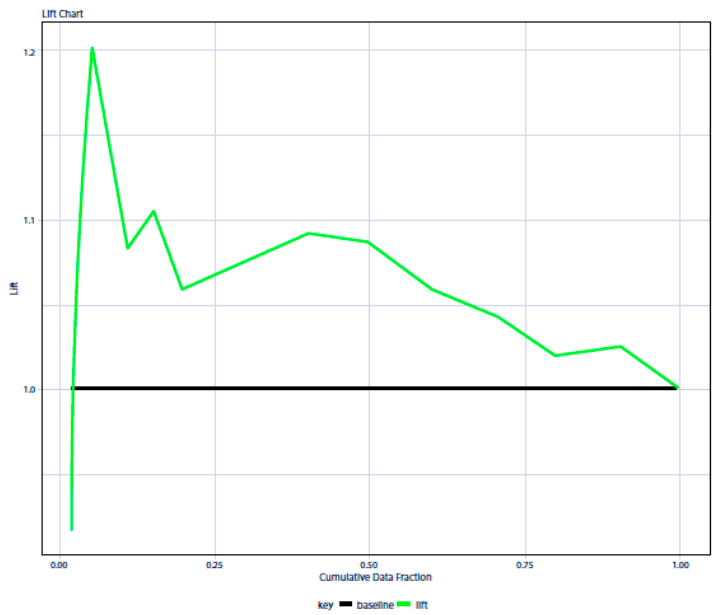
Figure 5. Lift chart for the mixed student sample.